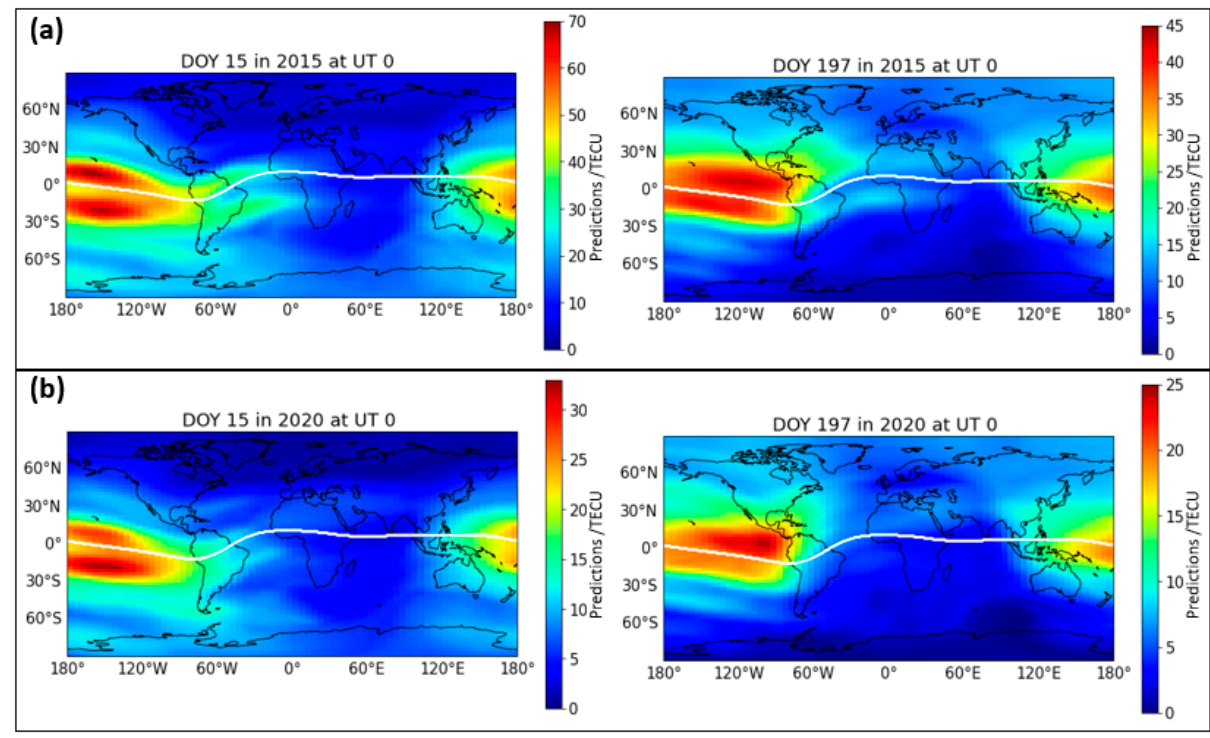
Figure 5. ( a ) VTEC measured for day of year (DOY) 15 and 197 at UT 0 for 2015; ( b ) VTEC measured for DOY 15 and 197 at UT 0 for 2020, with the geomagnetic equator plotted as the white line.